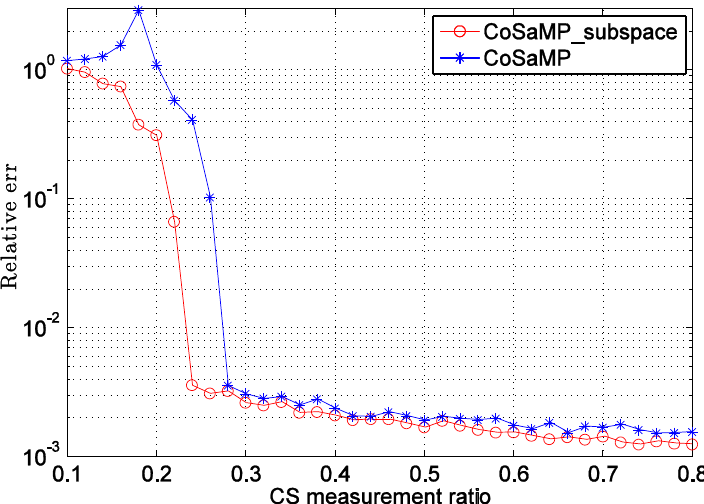
Figure 4. Performance comparison between CoSaMP_subspace and ordinary CS (CoSaMP) for noisy sparse recovery problem.